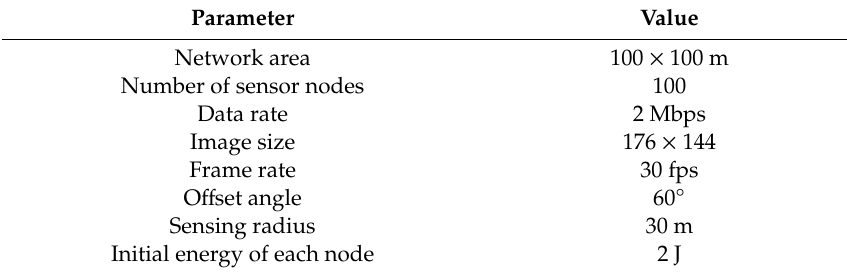
Table 3. Simulation parameters.